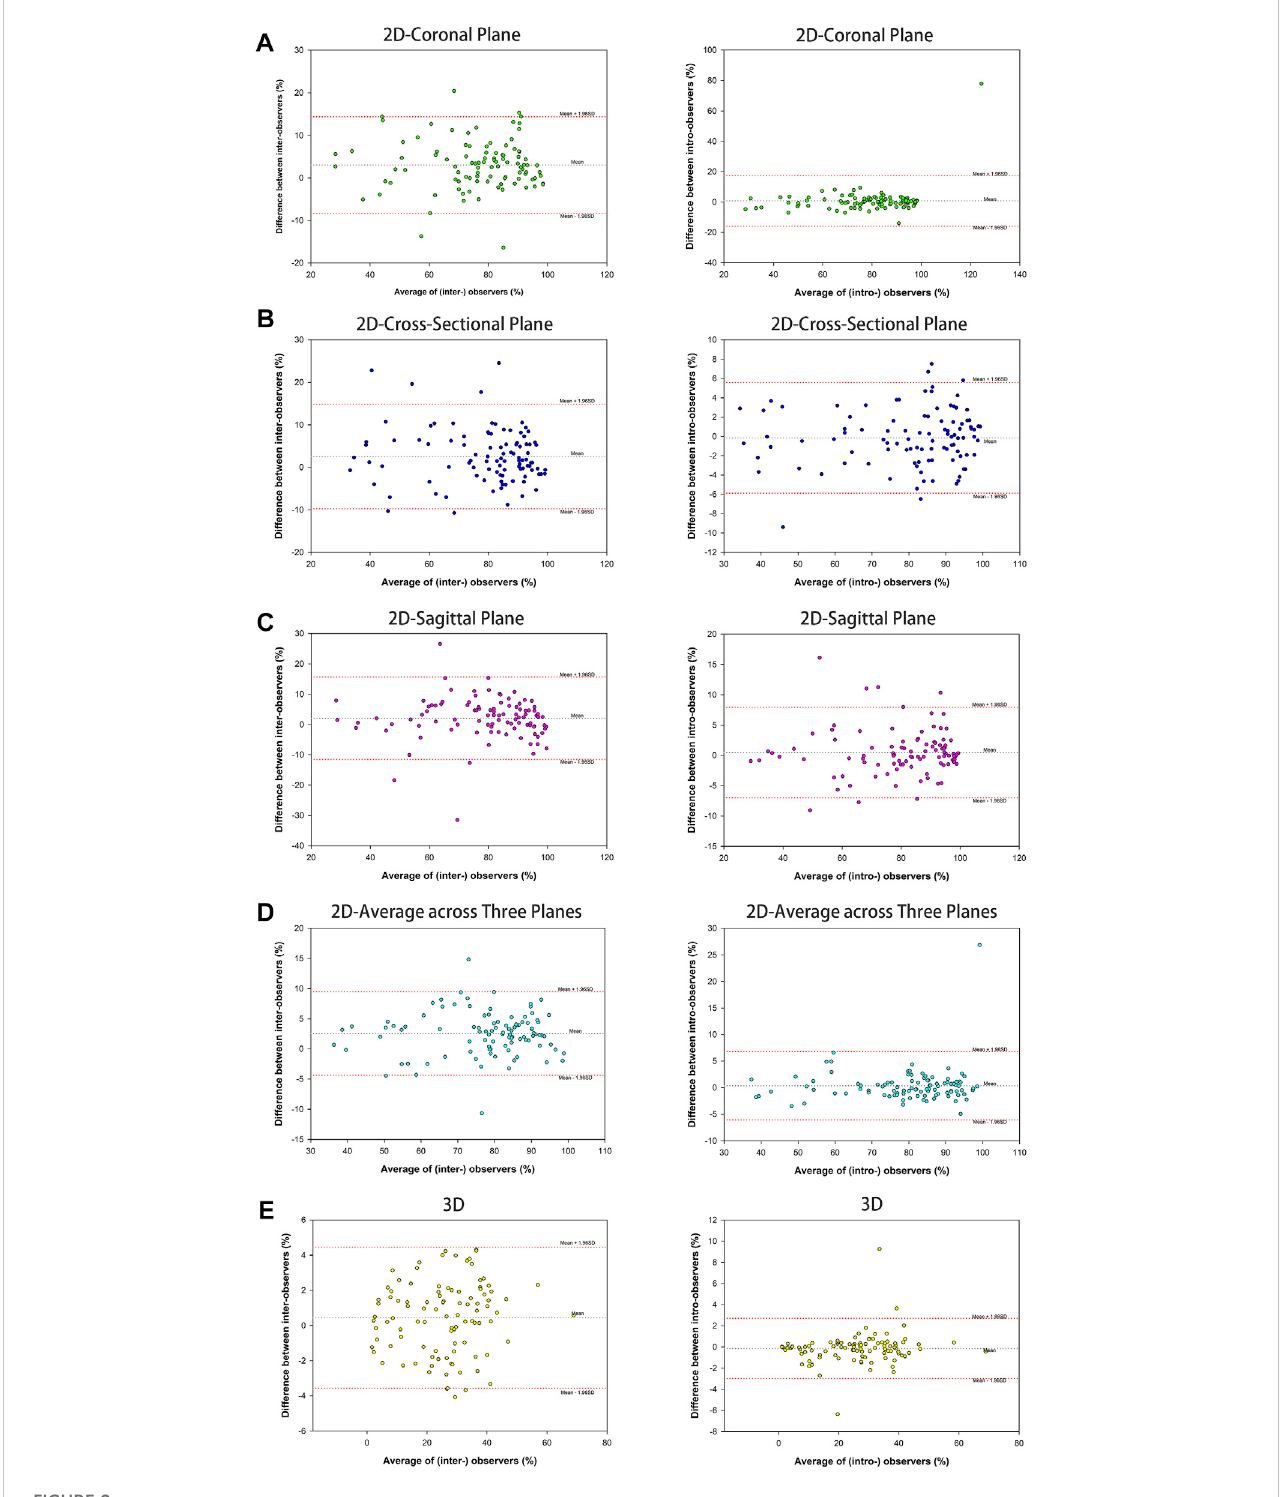
FIGURE 2 Bland-Altmanplotsofparametermeasurementshowedhighassessmentagreementofinter-observersandintra-observers,containing2Dparameterof the percentage of maximum defect length [coronal plane (A) , cross-sectional (B) , sagittal plane (C) , and average across three planes (D) ]and 3Dparameter of the percentage of fracture area (E)